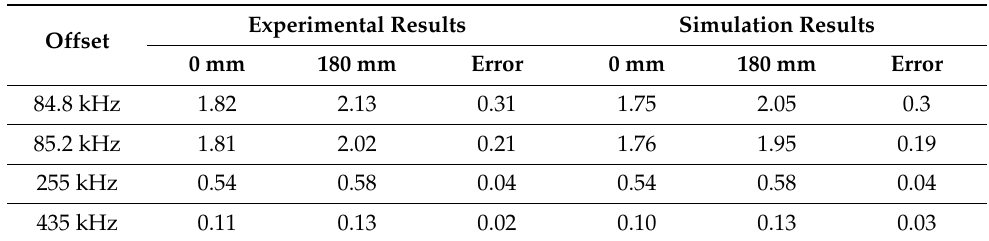
Figure 24. Magnetic induction intensity (pT) measurement of A3: ( a ) y -axis; ( b ) z -axis. Table 12. Magnetic field strength in the xy direction of sideband and harmonic currents with 30% offset (A/m).